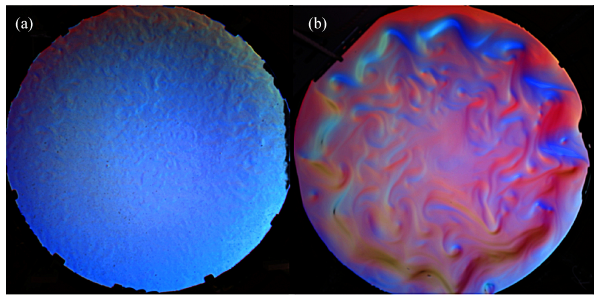
Figure 2. Typical images from video sequences recorded in the ex- periments with thermal (a) and saline (b) forcing. The flows are visualised by optical altimetry (AIV); different colours indicate dif- ferent values (both in magnitude and direction) of the gradient of the surface